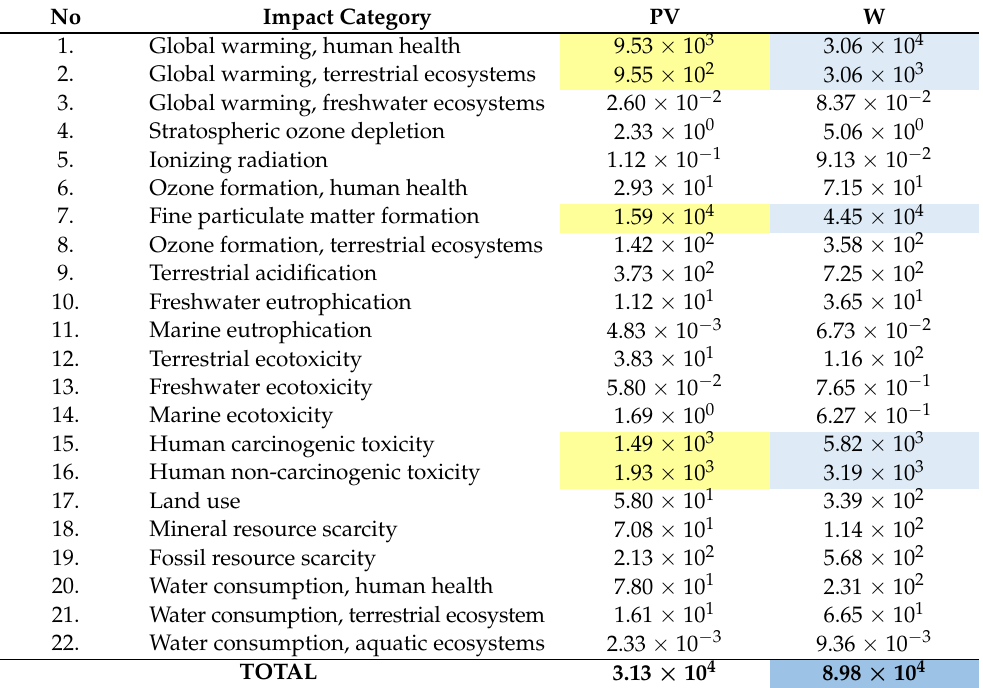
Table 1. Grouping and weighting results of environmental consequences occurring in the life cycle of wind (W) and photovoltaic (PV) power plants (unit: